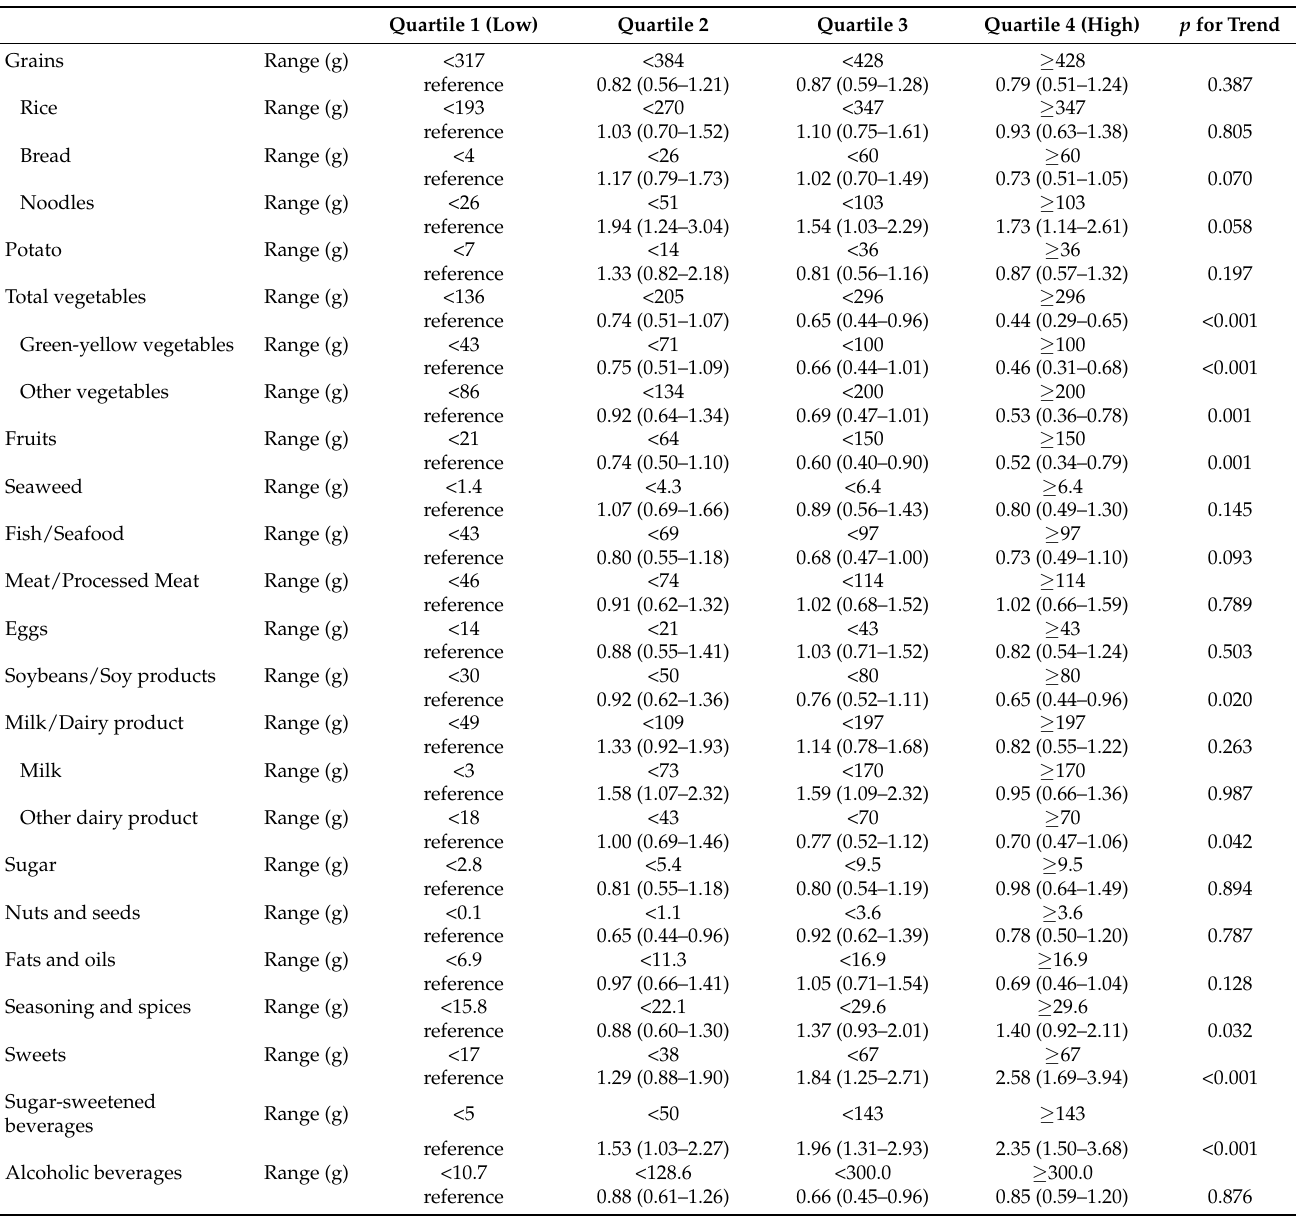
Table 3. Association between obesity and food groups according to quartiles with ranges by multi- variate quartile analysis